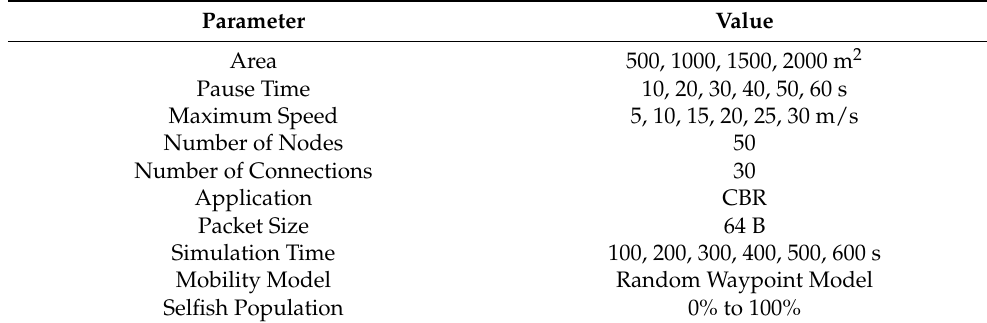
Table 2. Different simulation